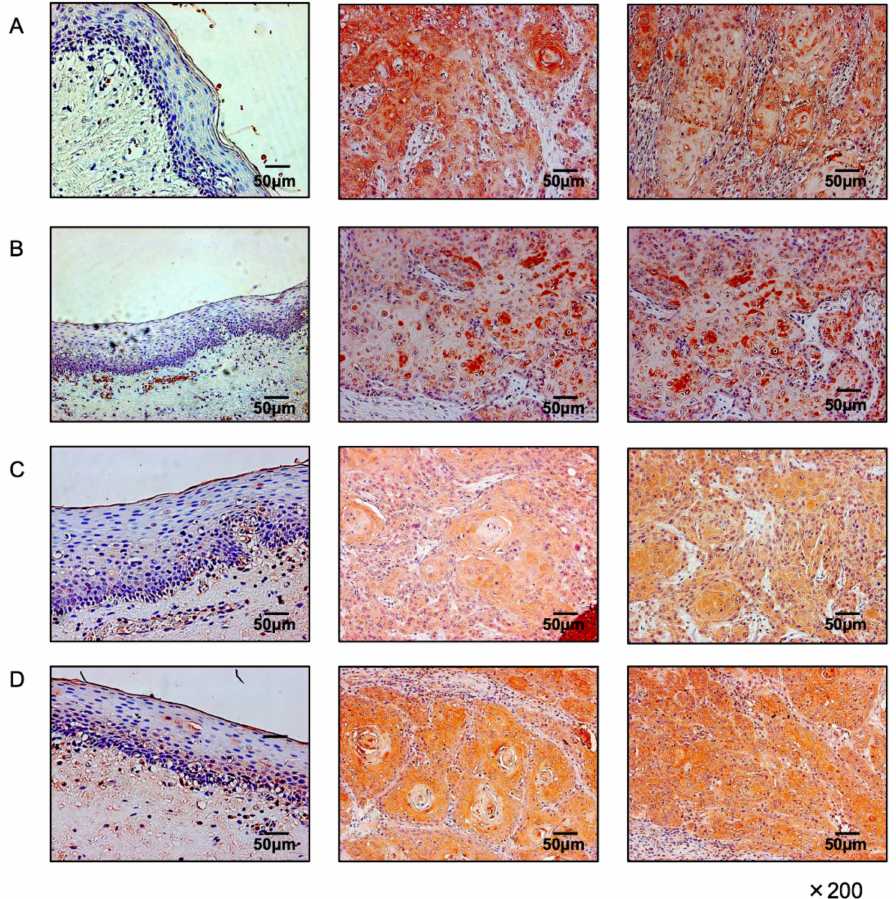
Figure 3. Overexpression of CORO2A in OSCC clinical specimens . Immunohistochemical staining of CORO2A in OSCC clinical specimens. High expression of CORO2A was detected in the nuclei and/or cytoplasm of cancer cells (( A – D ) center and right side) and weak expression in the normal oral mucosa (( A – D ) left